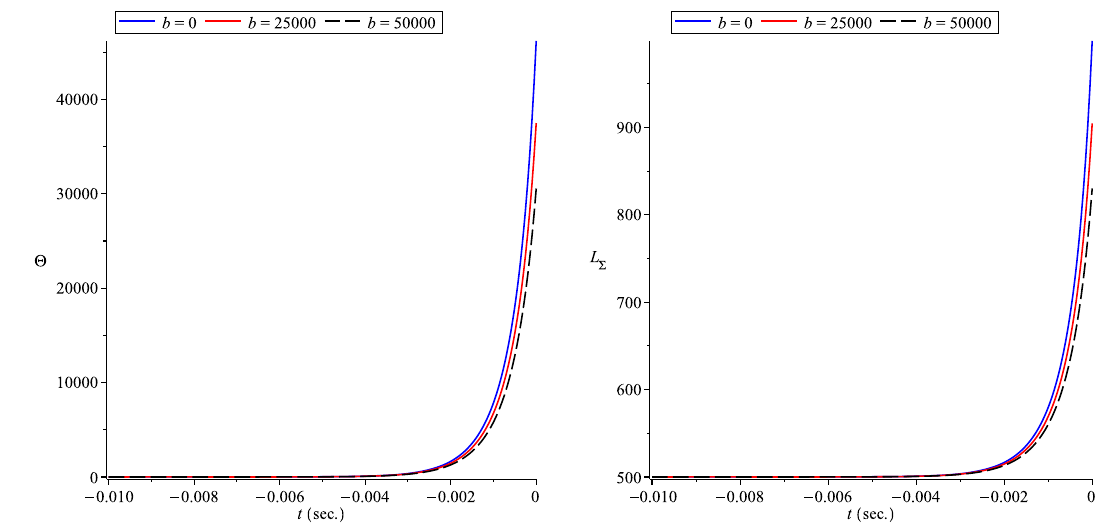
Fig. 2 (Left) the variation in collapse rate (cid:13) vs. t for different charge/mass ratios. With increasing charge the collapse of the star slows down. (Right) evolution of luminosity L (cid:16) with time t with different charge/mass ratios represented by b . The luminosity evolution also delays with increasing